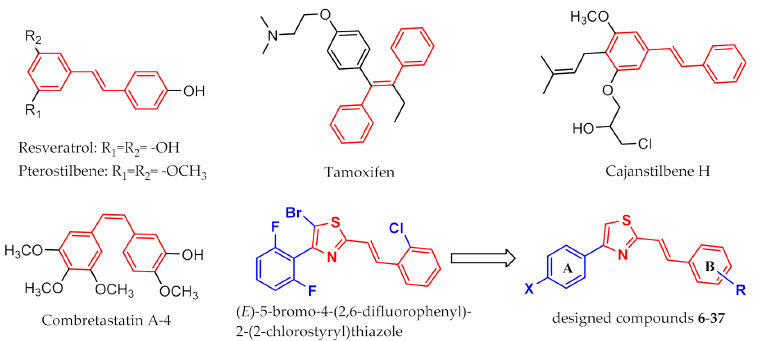
Figure 2. Chemical structures of several natural stilbene derivatives as anticancer agents, the stilbene analogue Top1 inhibitor in laboratory and designed compounds 6 - 37